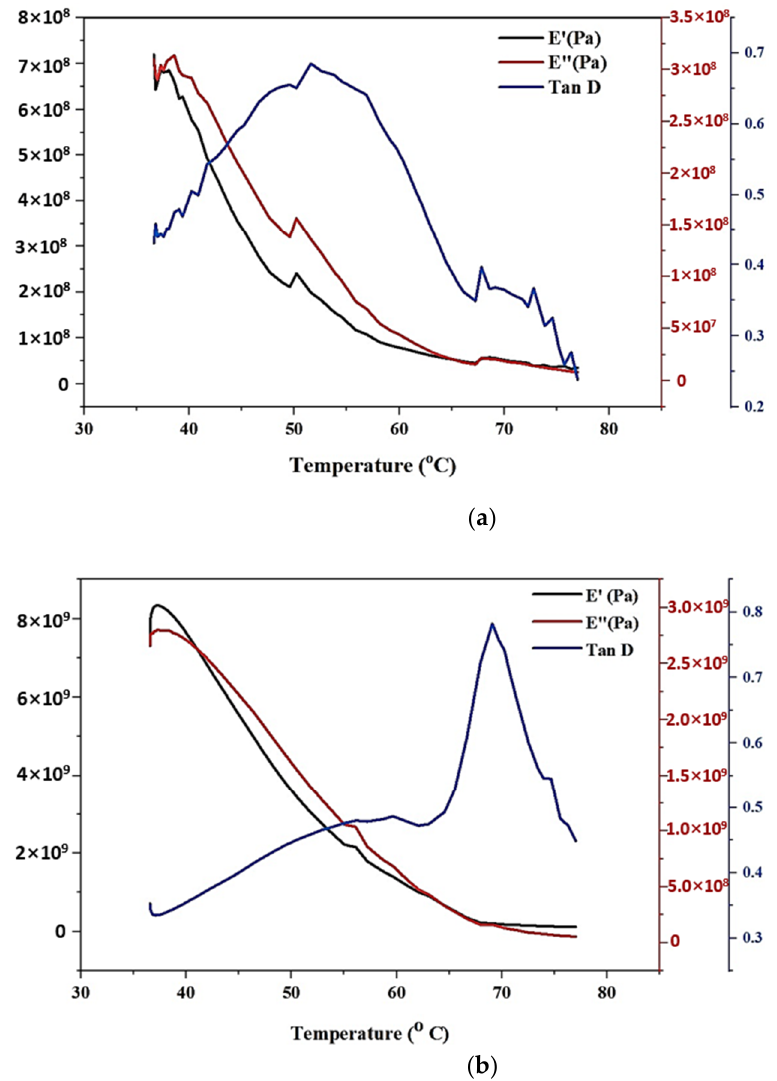
Figure 18. ( a ) DMA Analysis for 0.1% wt addition of Graphene Nanoparticles with tBA-co-DEGDA. ( b ) DMA Analysis for 0.3% wt. addition of Graphene Nanoparticles with tBA-co-DEGDA.